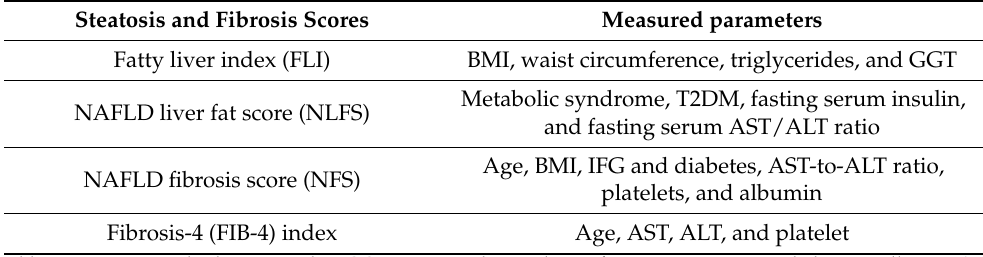
Table 2. Non-invasive biomarker detection methods [53,56].